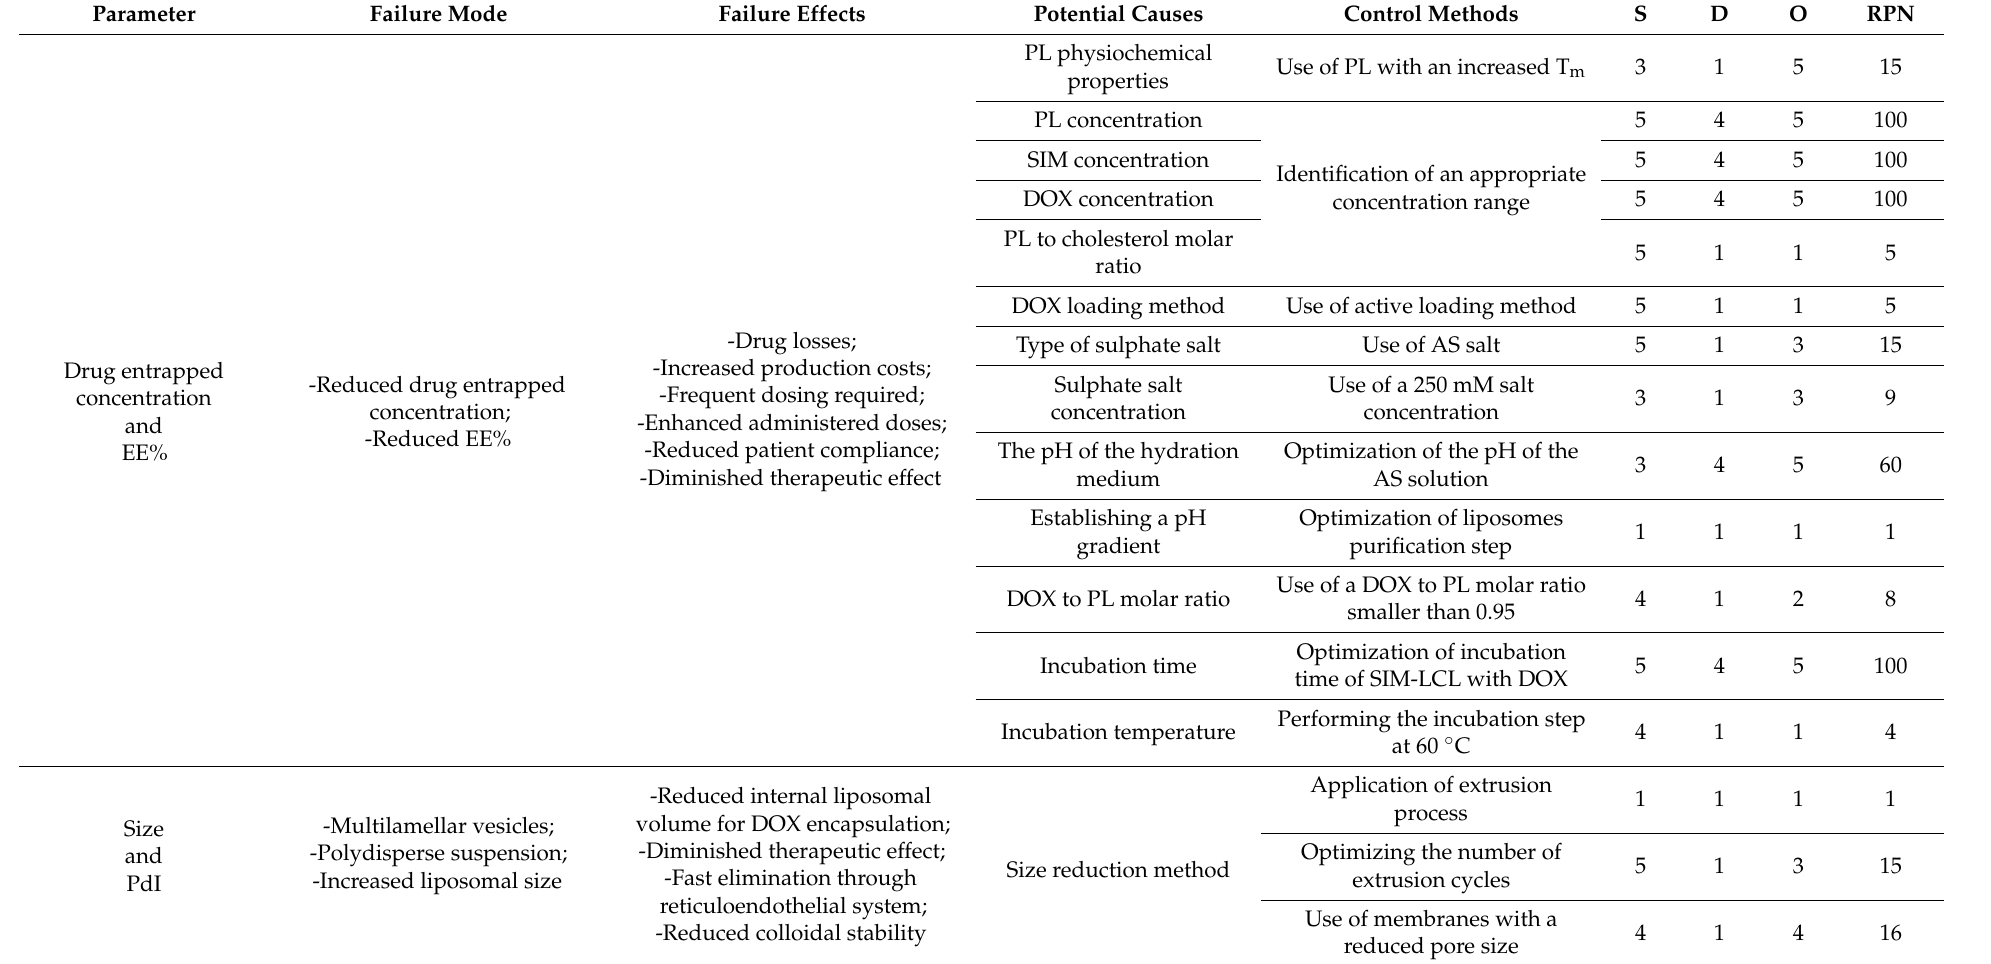
Table 3. Failure mode effects